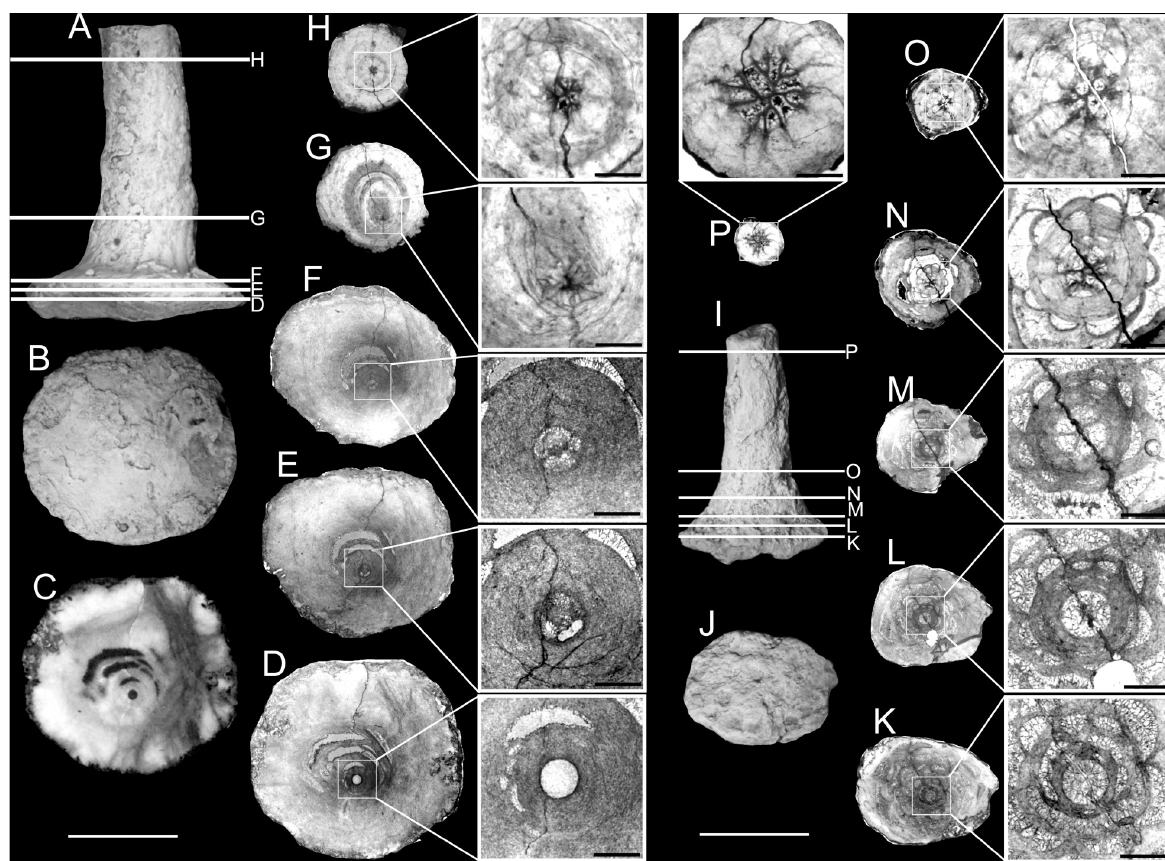
Fig 5. Two juvenile specimens of Oligophylloides sp.: A-H–UAM/He/B/018, I-P–UAM/He/B/019. A, B–external views (side and bottom); C– partly ground bottom part of the specimen (note empty hole in the centre and protoheterotheca with separated laminae of the attachment body); D-H–successive serial transversal sections (acetate peels and thin sections) showing successive ontogenetic growth stages. Enlarged parts of the sections indicating changes in the central lumen and surrounding protoheterotheca in squares. I,J–external views (side and bottom); K-P–D-H– serial transversal sections (acetate peels and thin sections) showing successive ontogenetic growth stages. Enlarged parts of the sections indicating changes in the central lumen and surrounding protoheterotheca in squares. Scale bar 2 mm, scale bars in the enlarged parts 1 mm.